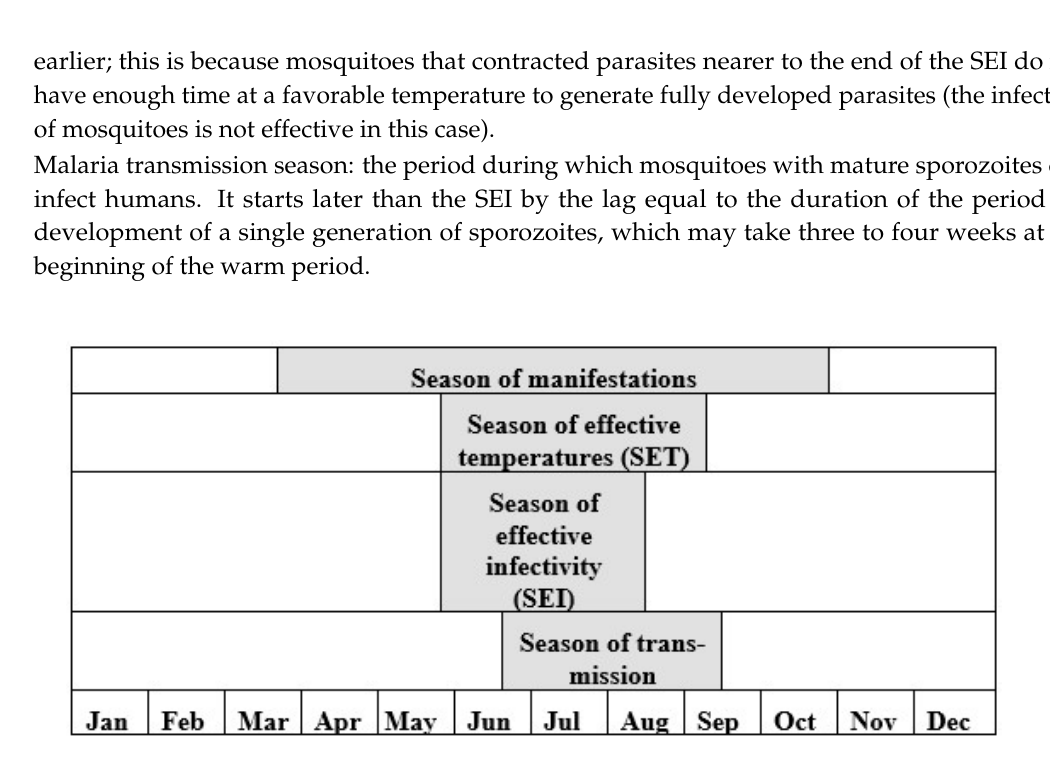
Figure 4. Interrelation of the elements of malaria season (e.g., in Central Russia), adopted from [30].